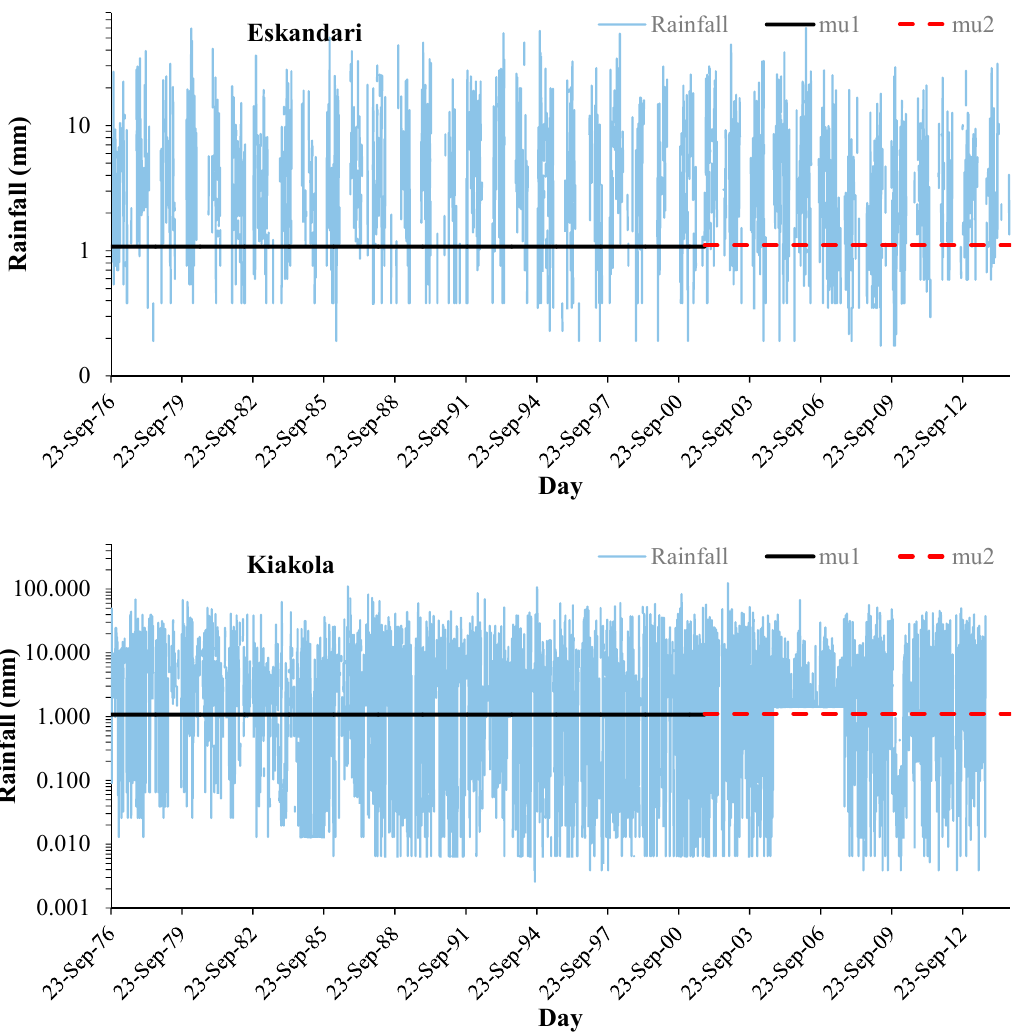
Figure 5. Pettit’s test for rainfall time series.